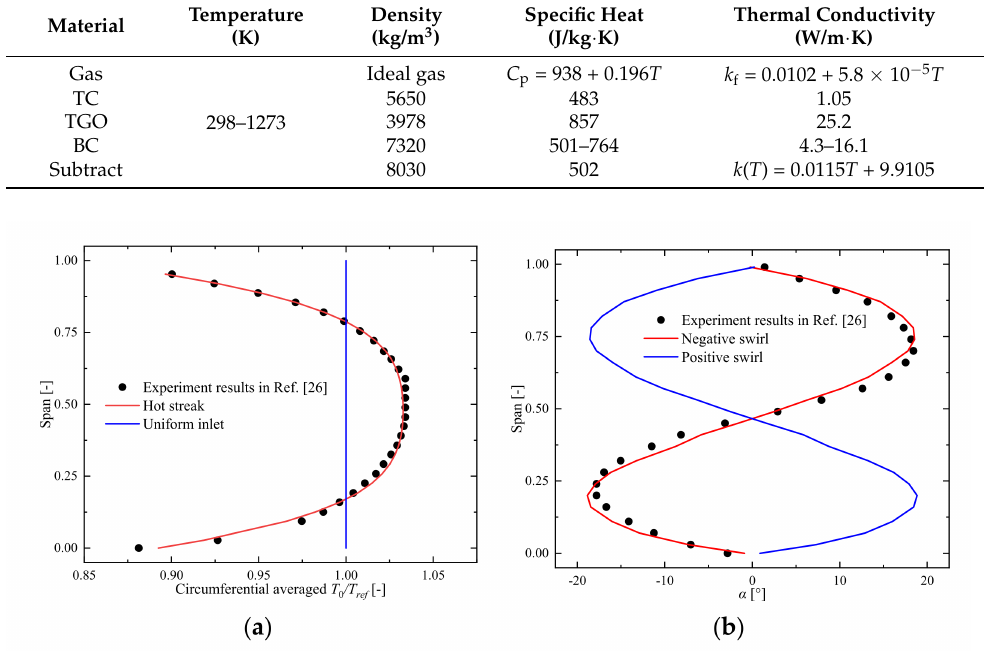
Figure 5. Circumferential averaged temperature and swirl angle profiles [26]. ( a ) Temperature profile; ( b ) Swirl angle